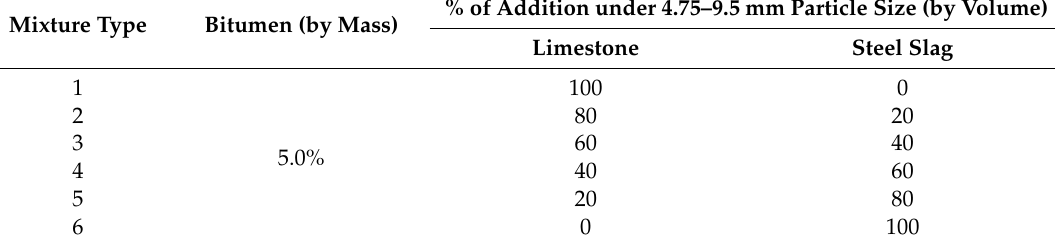
Table 3. Mix proportion for Marshall